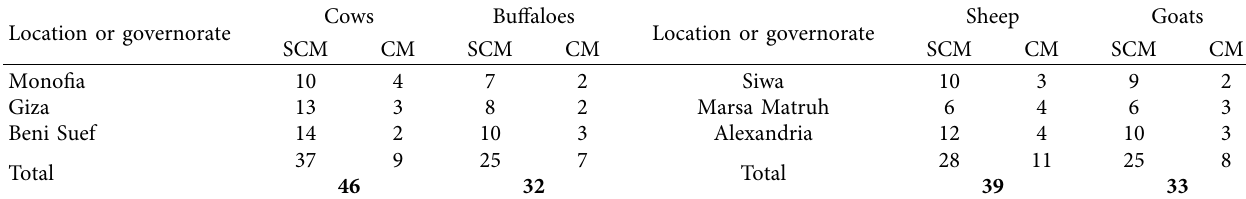
Table 1: Samples collected from diferent dairy